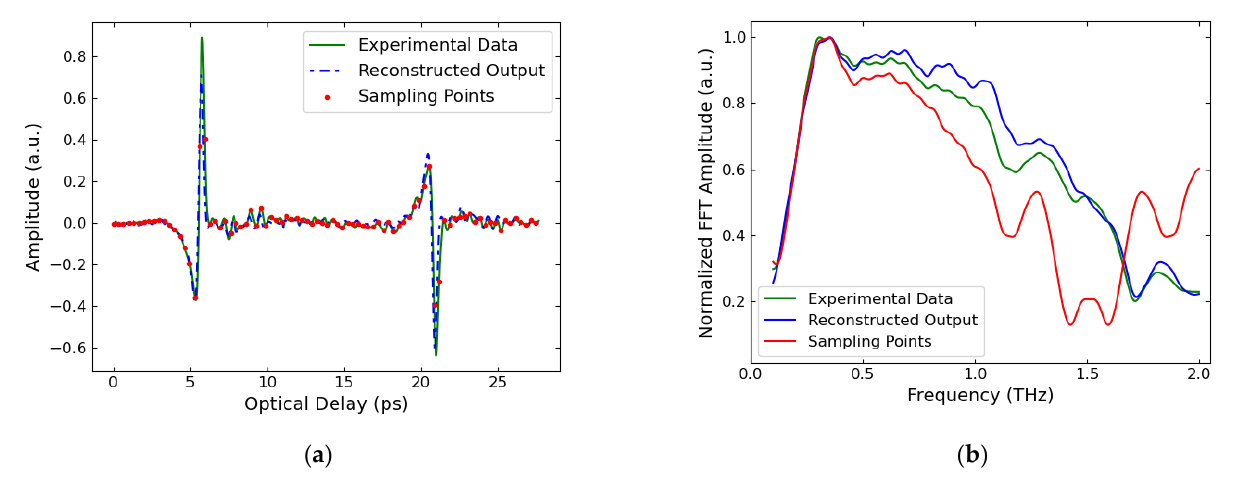
Figure 4. Experimental verification of our THz FRI method. ( a ) The raw data, shown by the green line, are reflections off the sides of a thick plastic block. The sampling points are shown by the red dots, which were used as the input for the method. The resulting reconstruction is shown by the dashed blue line. ( b ) The normalized FFT spectra for these data.